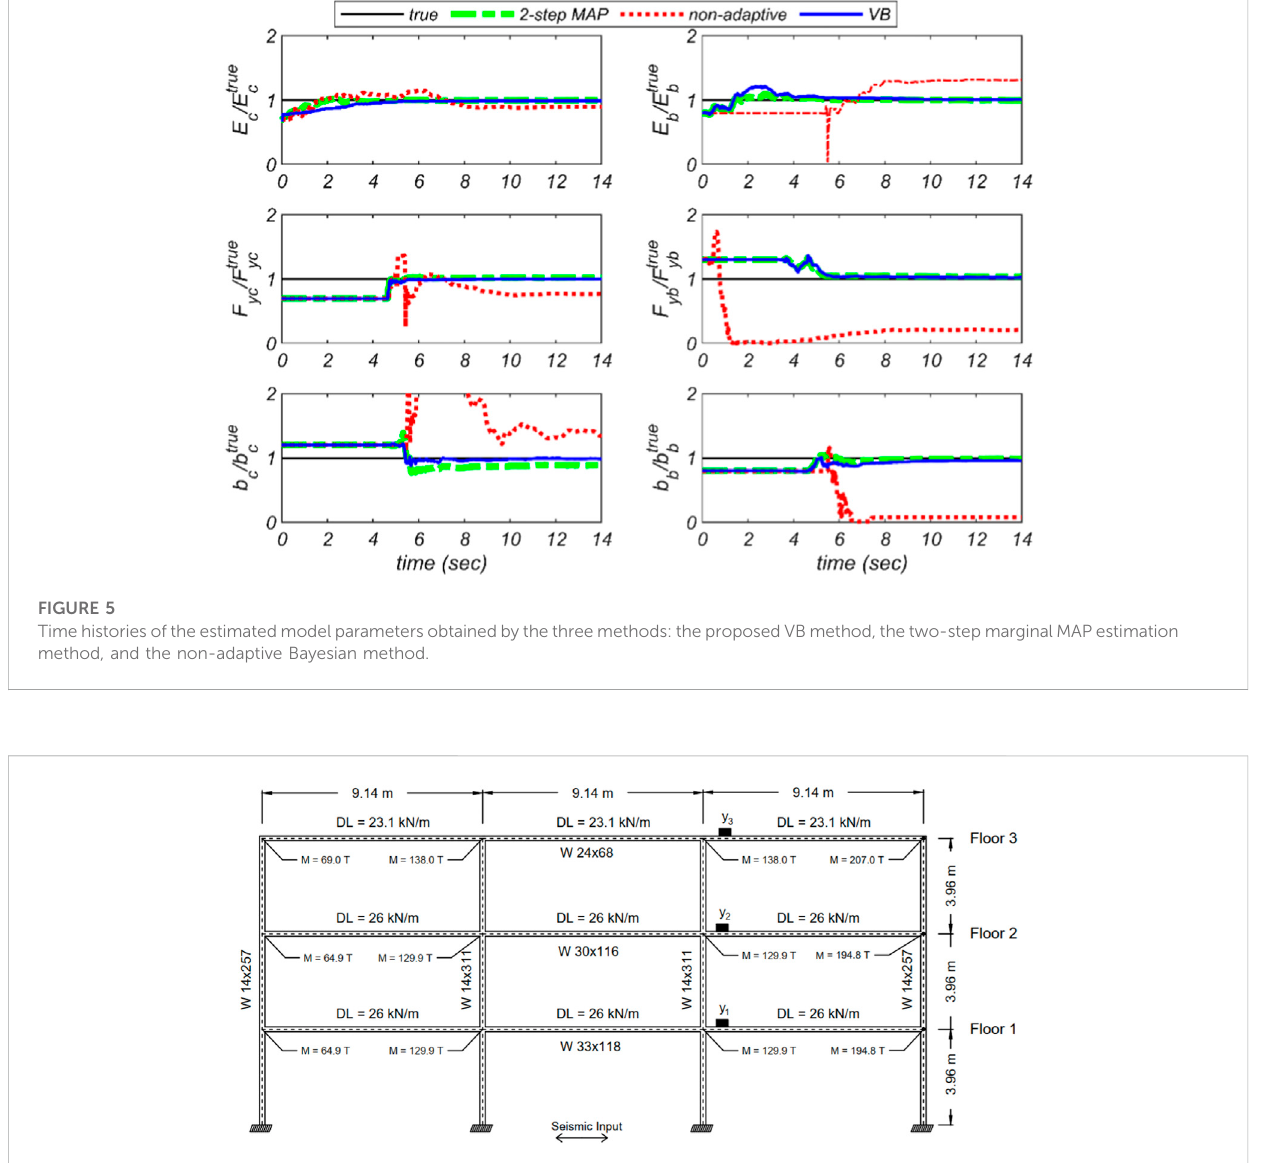
FIGURE 6 3-Story 3-bay steel moment